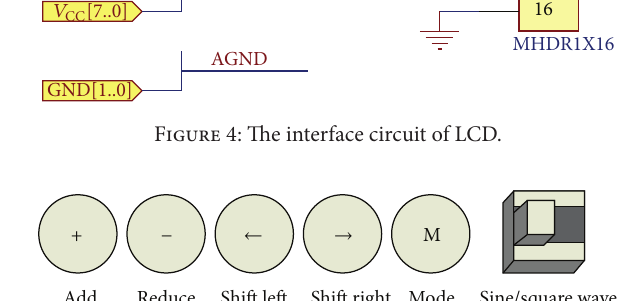
Figure 5: The shifting keyboard panel